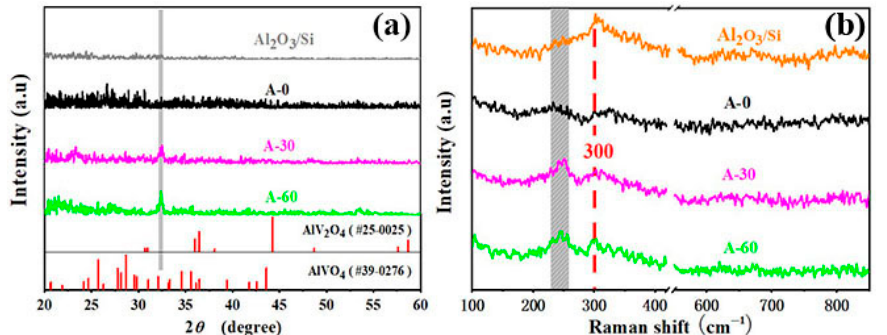
Figure 1. XRD patterns ( a ) and Raman spectrum; ( b ) of A-series samples with different annealing- time. Al 2 O 3 /Si annealed at 750 °C for 60 min is used as a reference. 0, 30 and 60 (with a unit of minutes) represent the annealing-time. The standard XRD data from JCPDS of AlV 2 O 4 and AlVO 4 are attached for a comparison.